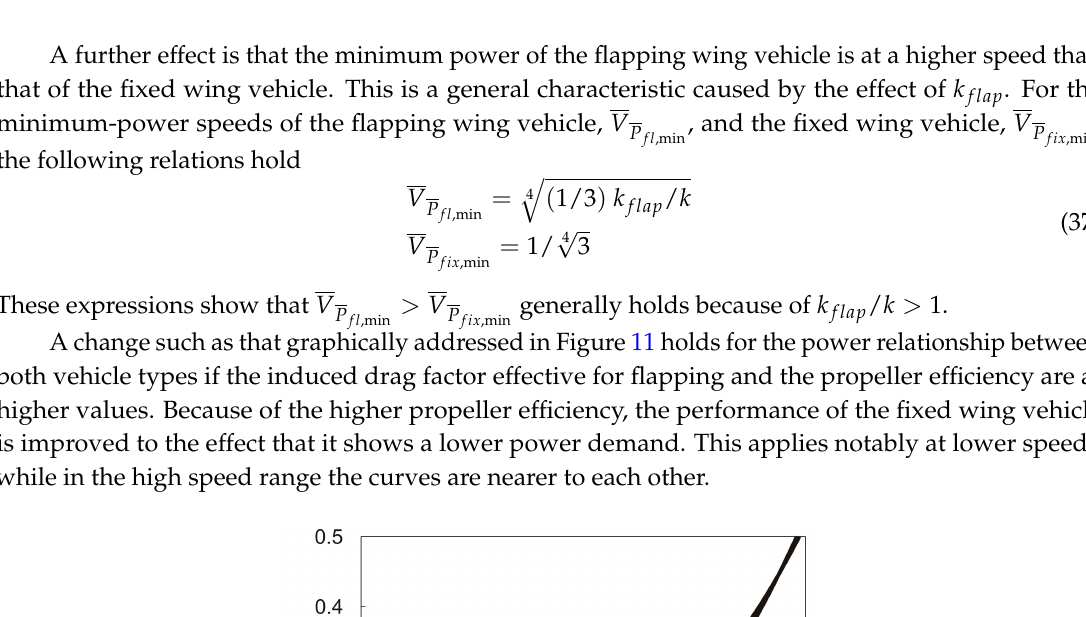
Figure 10. Power required in level flight ( k flap = 1.5, η prop = 0.5).